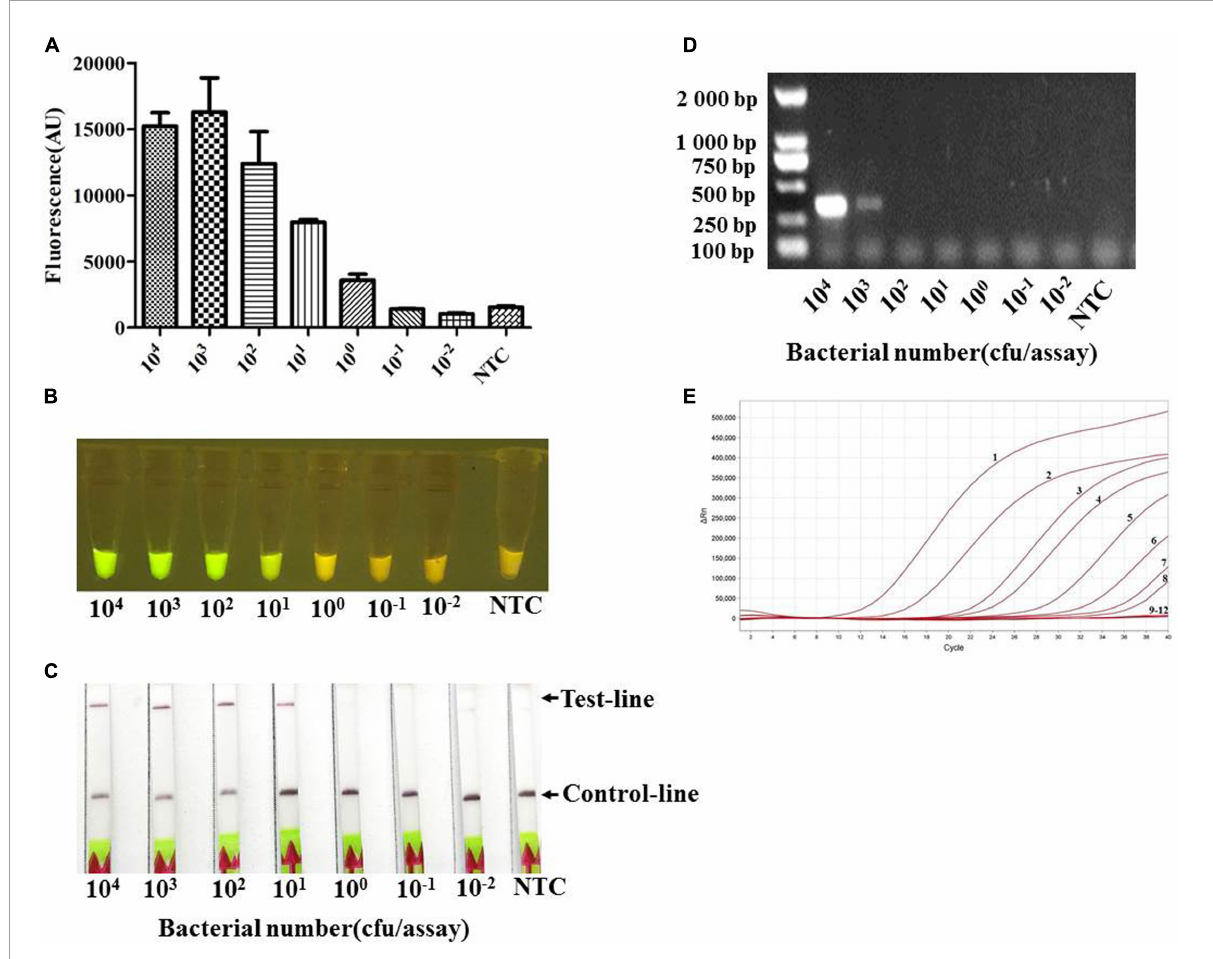
FIGURE6 The limit of detection (LOD) of the Card platform for a pure culture of App S8 serovar 7. The LOD for different CFUs was determined by using the genomic DNA from serial dilutions of pure culture as a template. (A) Endpoint fluorescence of RPA amplification products detected in a fluorescence microplate reader. Error bars represent the standard deviations of the mean of the three replicates ( n = 3). (B) Visual detection of RPA amplification products under blue light: positive samples appear green and negative samples appear yellow. (C) Detection of RPA amplification products in a lateral flow strip format. A purple control line is present in all lateral flow strips, but an additional line is present when the genomic DNA was detected by the Card platform. (D) The genomic DNA from serial dilutions of pure culture was detected by the PCR. (E) The genomic DNA from serial dilutions of pure culture was detected by quantitative real-time PCR. The numbers 1–8 represent the CFUs from 10 8 to 10 1 per assay, numbers 9–12 represent the CFUs from 10 0 to 10 − 2 , and NTC (non-template control) per